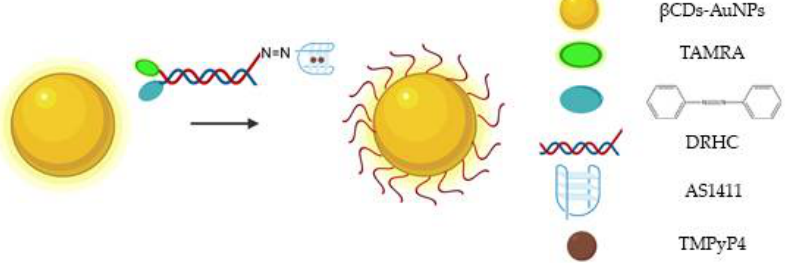
Figure 9. Schematic representation of AS1411-functionalized βCDs-AuNPs, which also contain: hy- poxia-induced cleaved azobenzene bridges, DRHC tagged with TAMRA and the photo-sensitizer TMPyP4